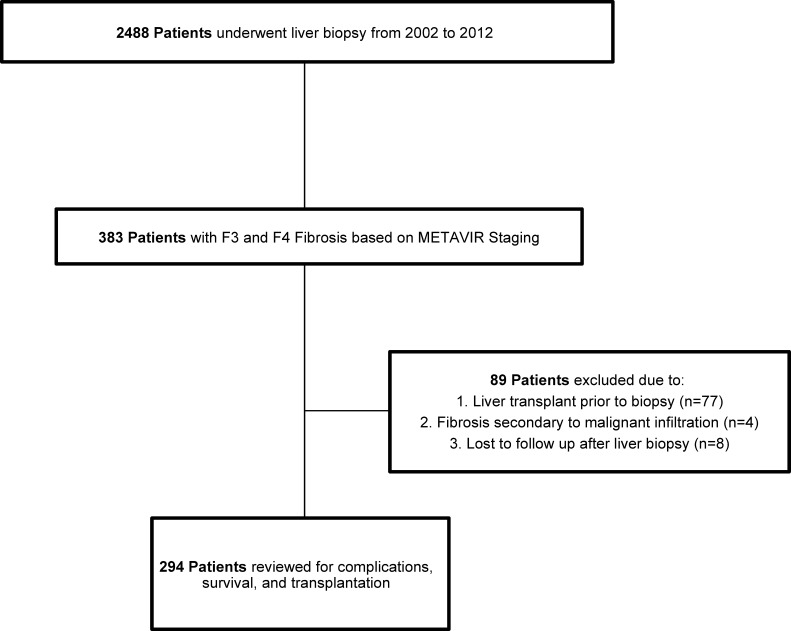
Cohort study design.